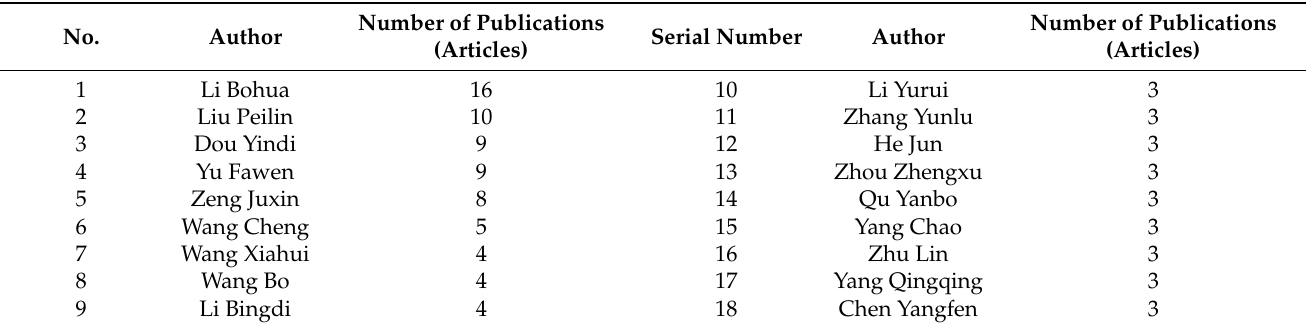
Table 1. Statistics on the number of papers published by certain authors on rural human settlements from 2013 to 2022.